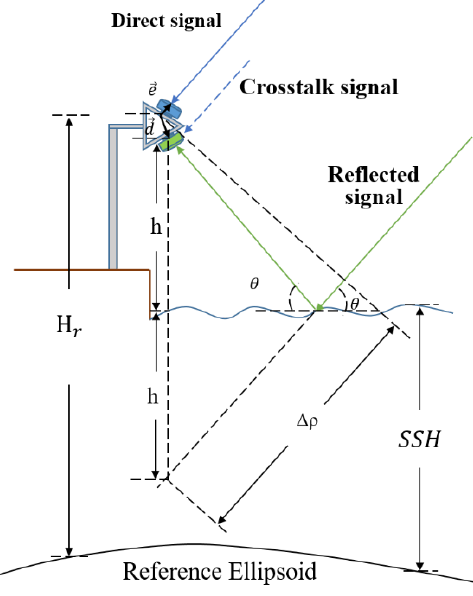
Figure 2. The geometry of coastal GNSS-R altimetry.